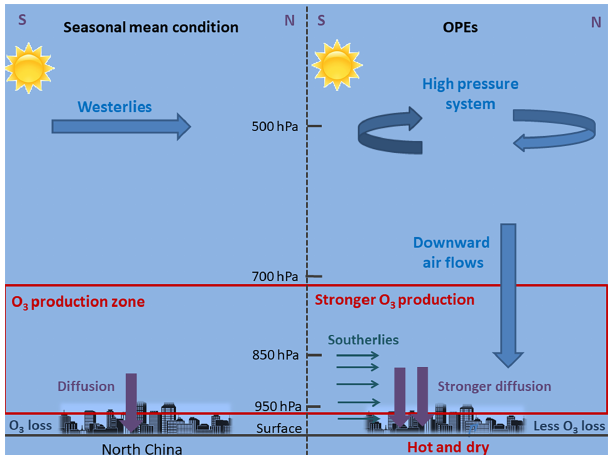
Figure 11. A schematic diagram of the typical weather pattern showing the mechanisms for the formation of OPEs in North